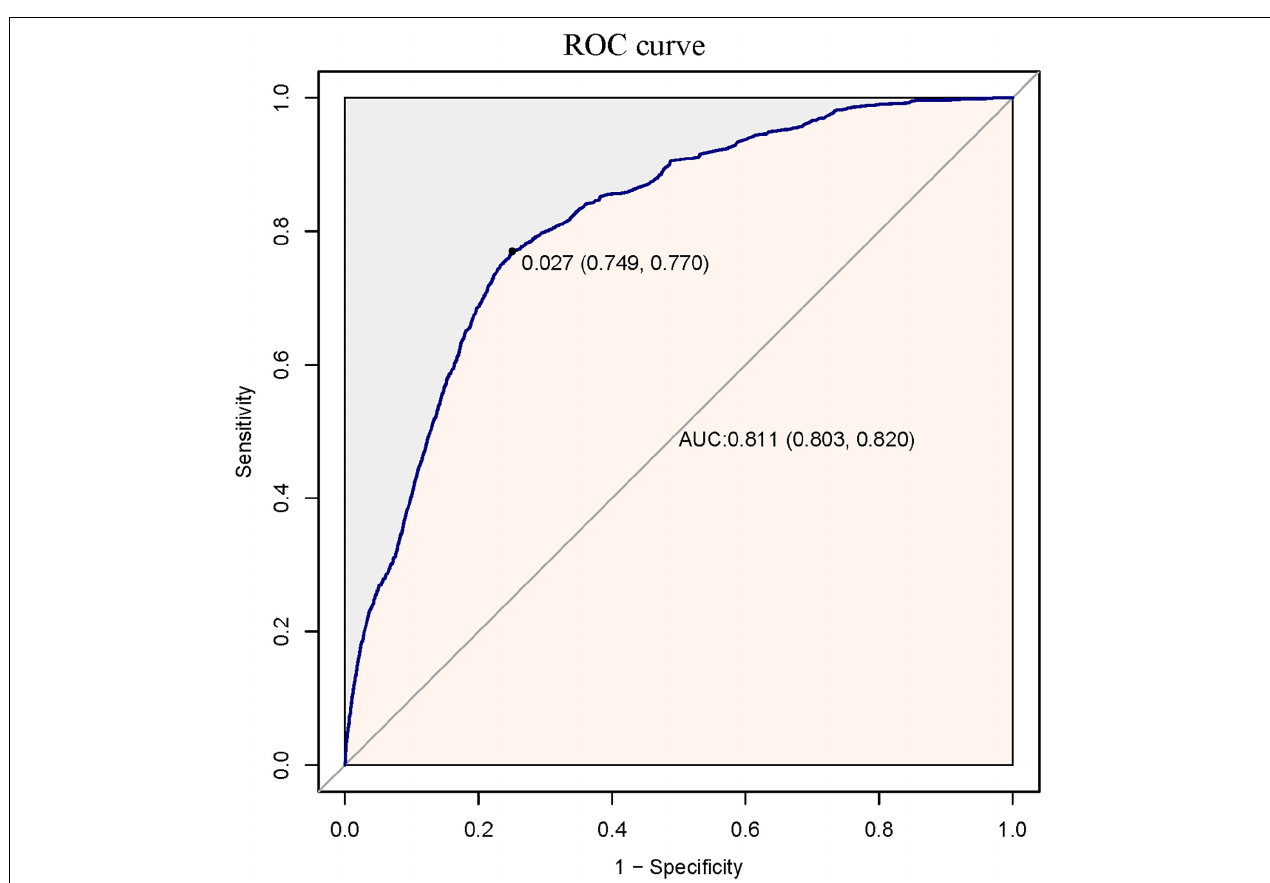
FIGURE 2 | The ROC curve of propensity score to predict one-year mortality after surgery. It showed that the logistic model used to estimate the propensity score yielded a c-statistic of 0.811.